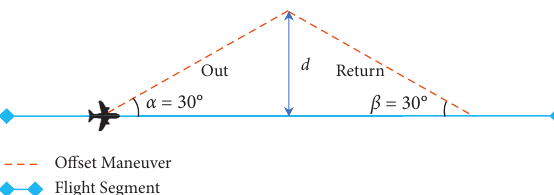
Figure 5: The diagram of the left offset: there are two “Out” and “Return” stages.